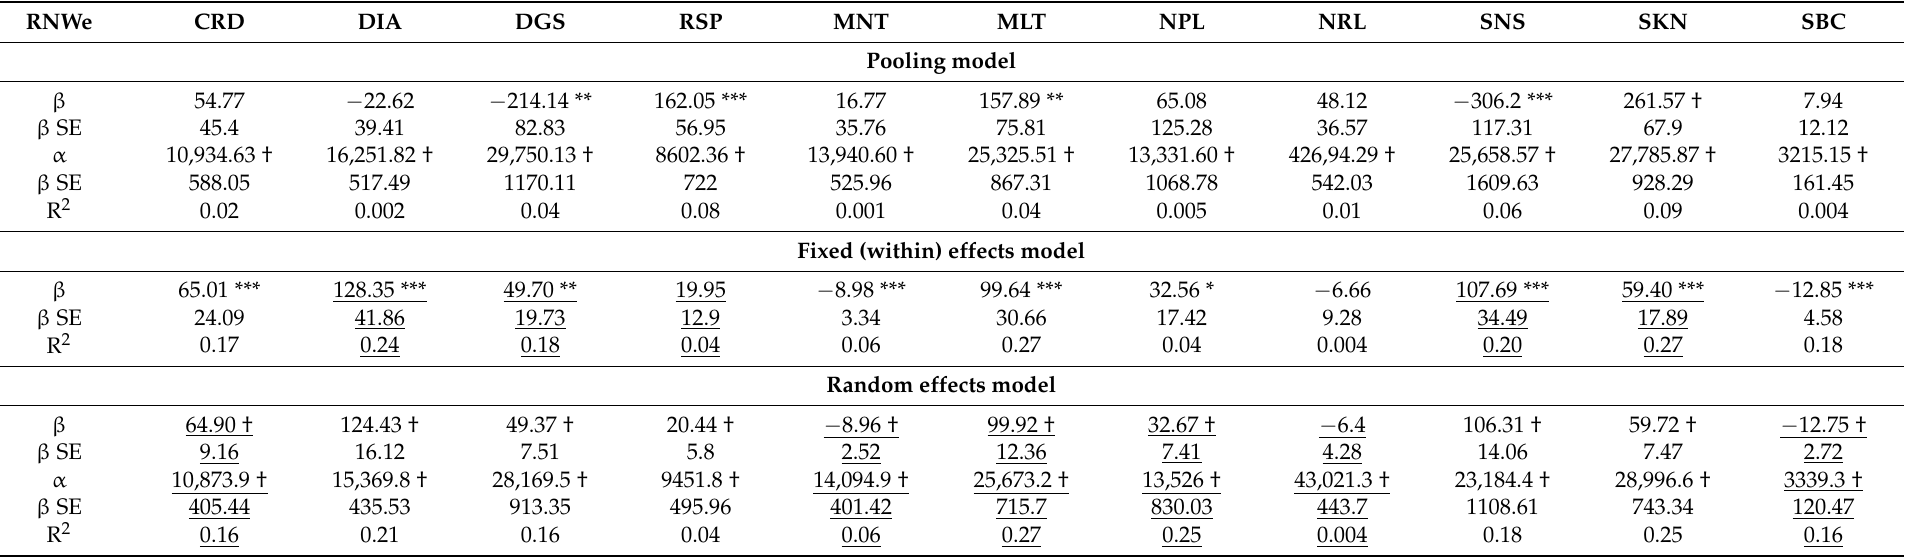
Table 4. Outputs of PLM models: RNWe transport (%) → prevalence of selected diseases (per population of